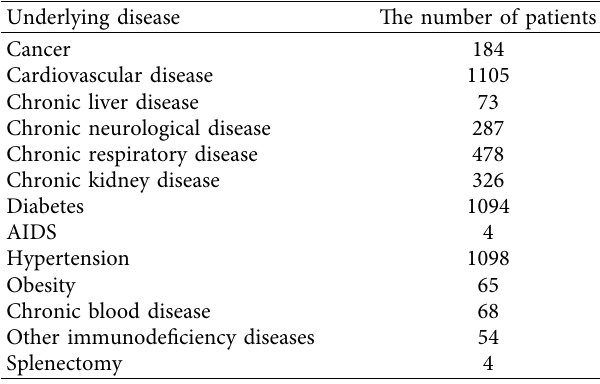
Table 1: The number of COVID-19 patients with each underlying disease.